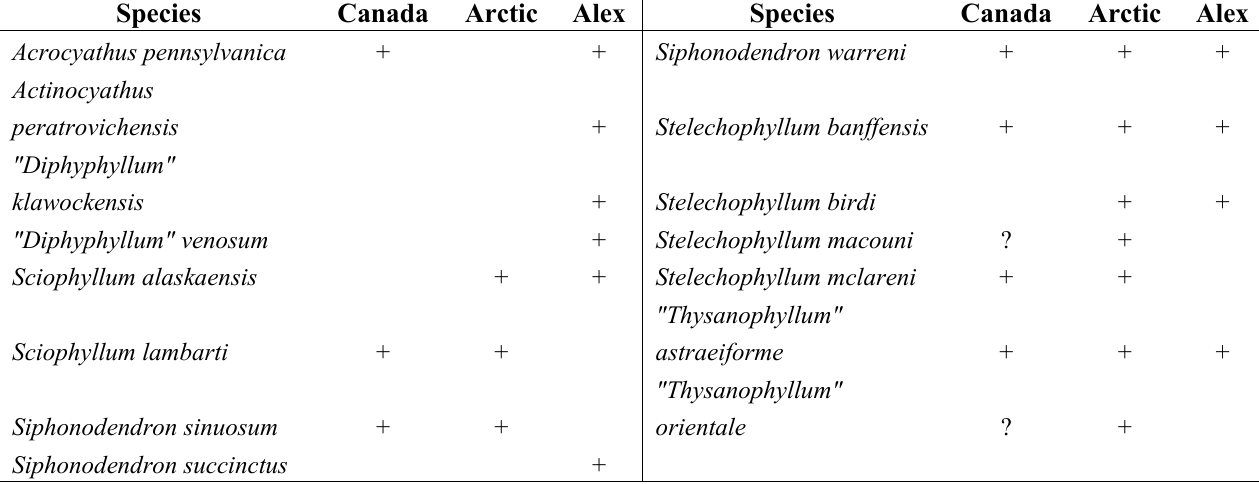
Table 2. Mississippian Colonial Rugose Coral Species. Canada = Canadian Cordillera; Arctic = Arctic Alaska; Alex = Alexander terrane.